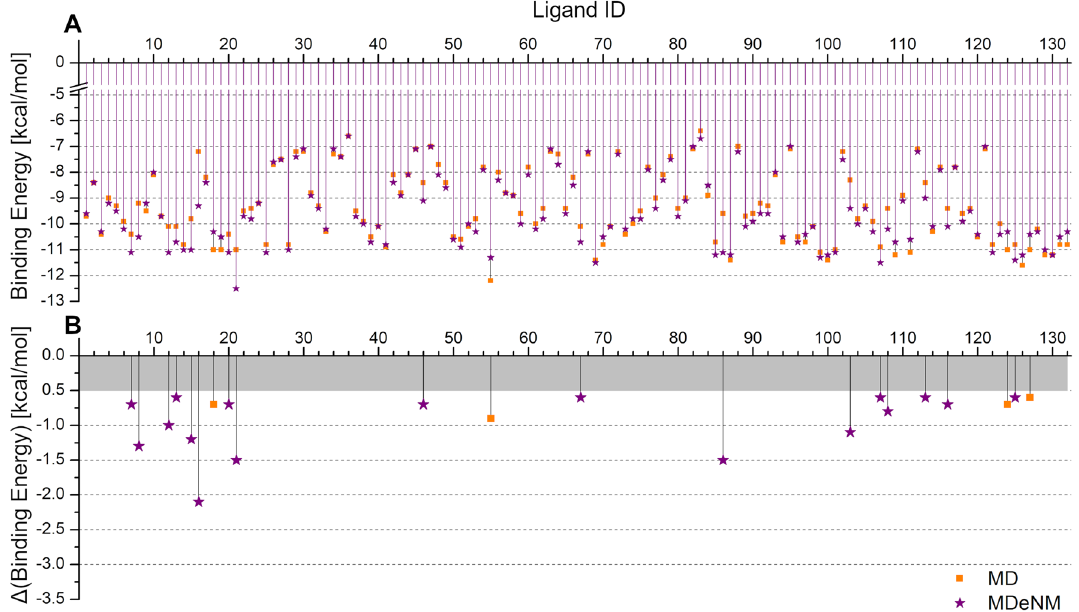
Figure 4. ( A ) The lowest binding energy (BE) per ligand resulting from the docking of the set of 132 known ligands to the ensemble of representative structures after clustering of SULT1A1/PAPS obtained from the MD (denoted by orange squares) and MDeNM (denoted by purple stars) simulations. ( B ) Differences between the best BEs retained for the MD and MDeNM conformations; for the better visualization, only differences larger than 0.5 kcal/mol are